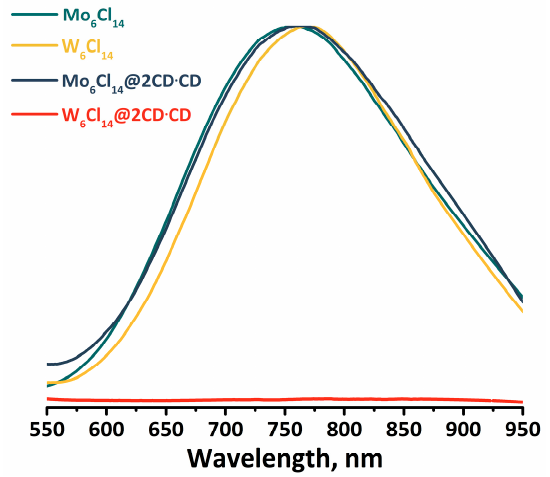
Figure 5. Normalized and smoothed emission spectra of compounds in solid state. Table 1. Main photophysical characteristics of clusters M 6 Cl 14 and inclusion compounds